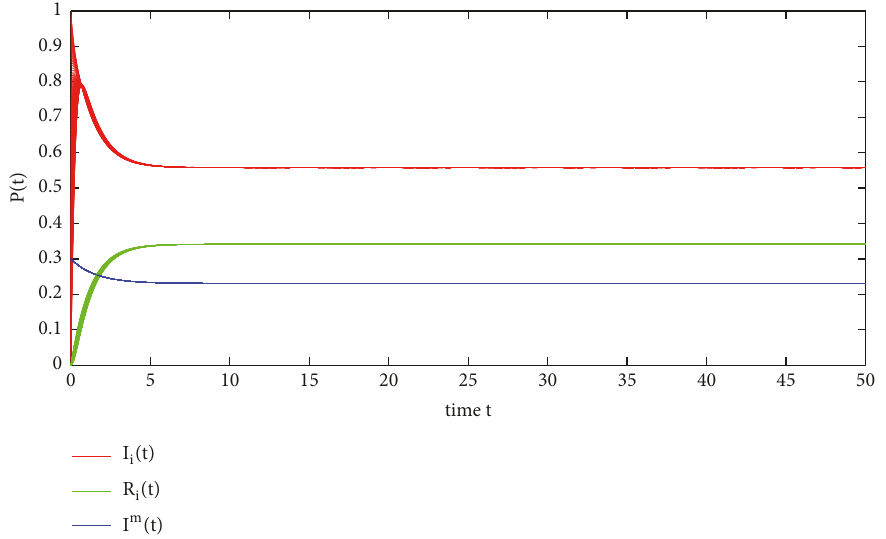
Figure 2: The states 𝐼 𝑖 (𝑡) , 𝑅 𝑖 (𝑡) , and 𝐼 𝑚 (𝑡) of time for fully connected networks and random initial conditions.